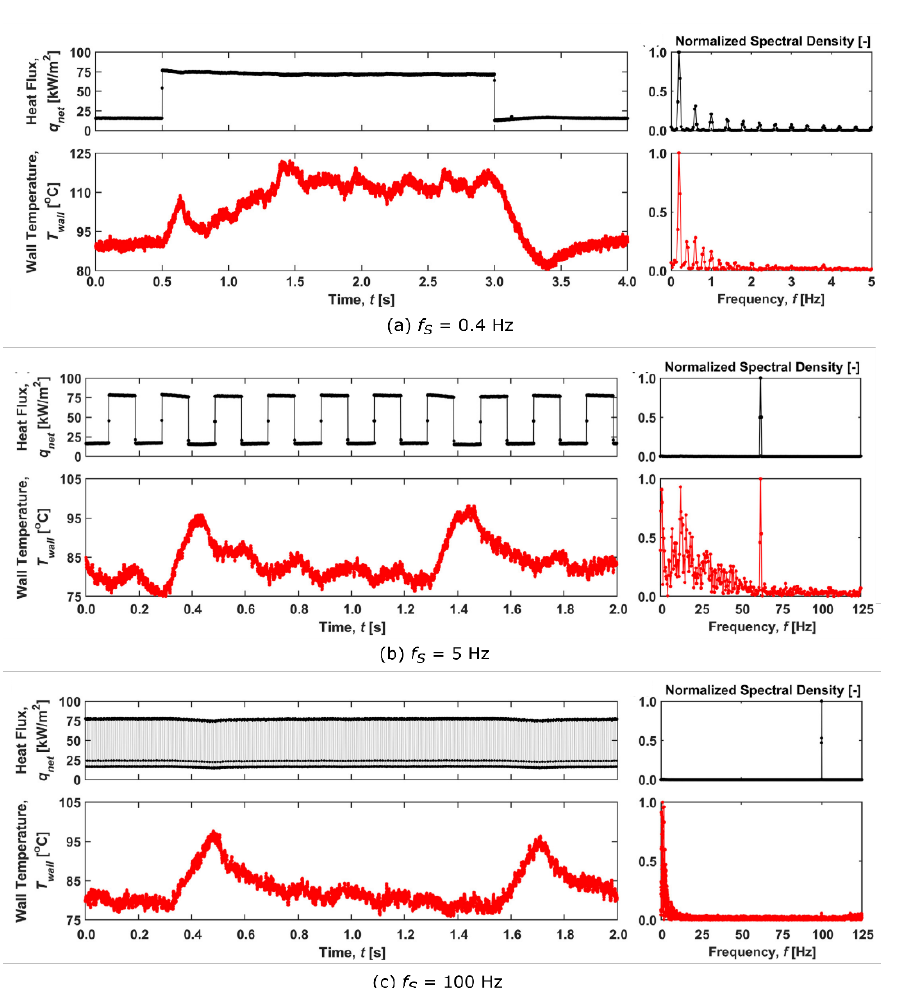
Figure 12. Active control of flow boiling using pulsed heating: temporal profiles and normalized spectral density of the heat flux and the wall temperature on a microchannel at different pulsating frequencies as measured in [52].